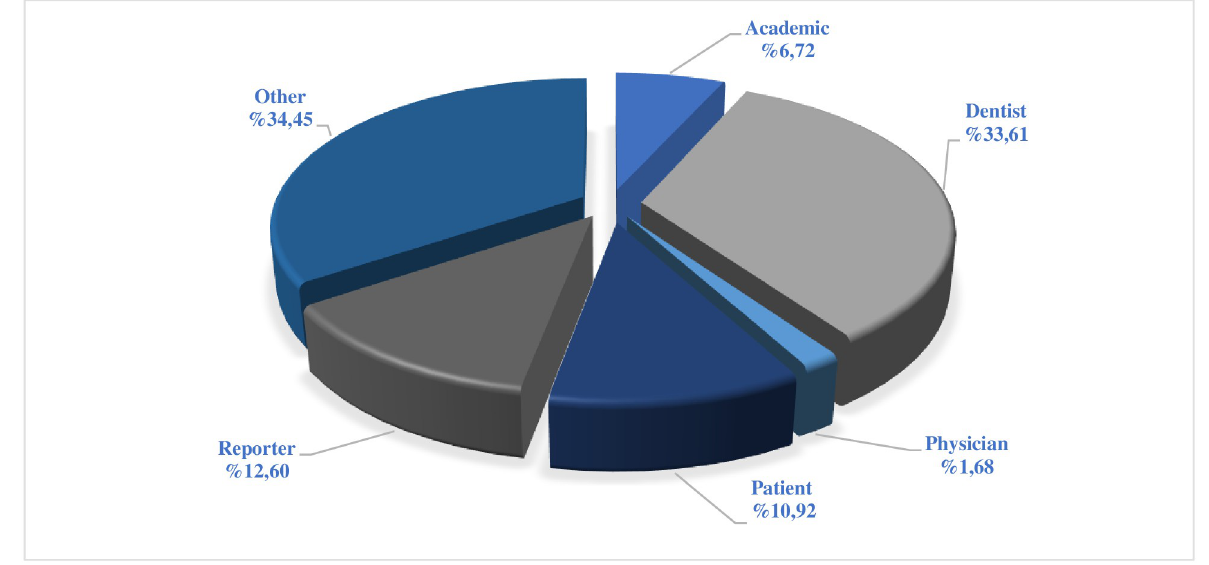
Fig 1. Classification of YouTube videos about pediatric dentistry according to the uploaded source.